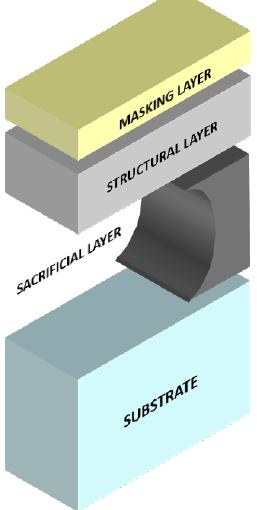
Figure 9. Three-D sketch of the proposed